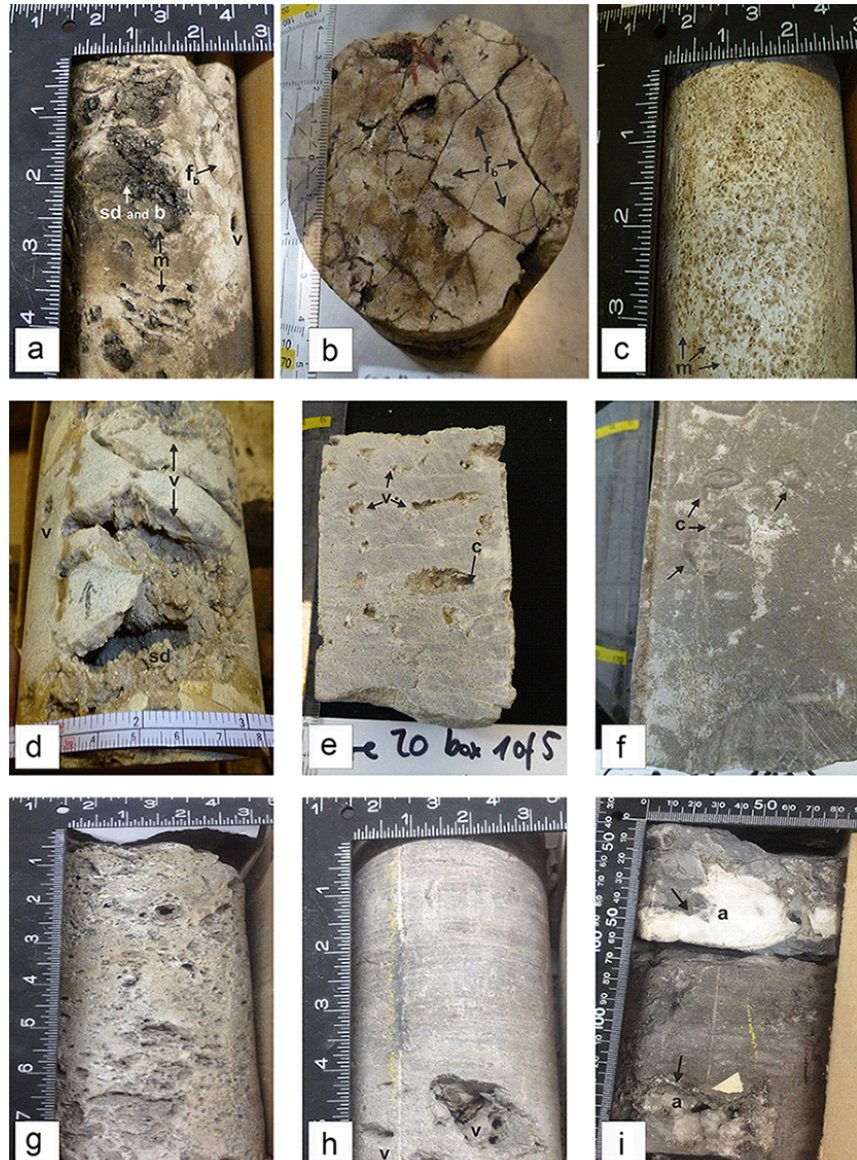
Plate A1. Representative core samples of the Leduc Formation from the RMRT and the SCCC. Except for (f) , all samples are dolostones. The scale bar is in inches and centimetres. (a, b) Light grey stromatoporoid floatstone (medium crystalline) with large vugs and abundant subvertical fractures ( f b ) filled with bitumen (1843.1m b.g.l., 5-22-48-27W4, RMRT). The notation “sd and b” stands for saddle